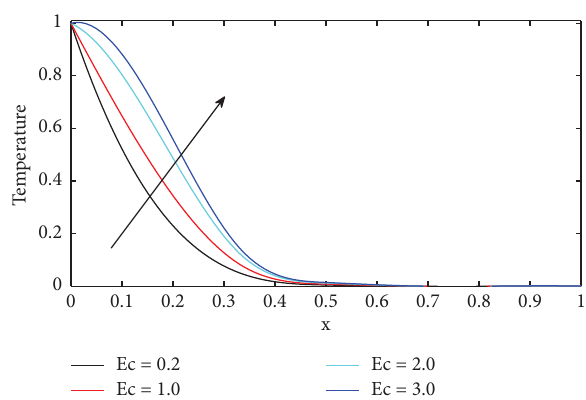
Figure 18: Temperature profles for diferent values of Ec